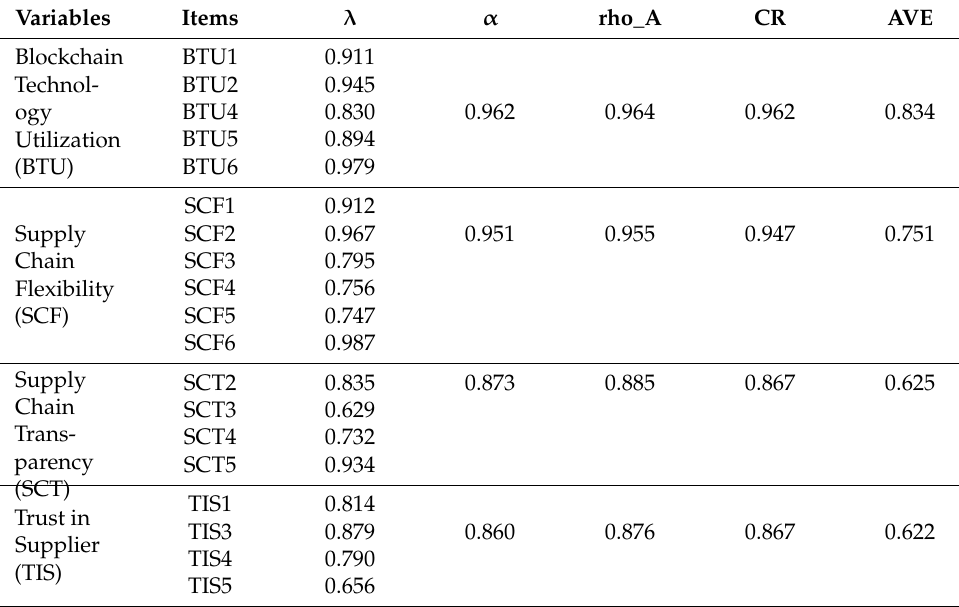
Table 2. Measurement model validity and